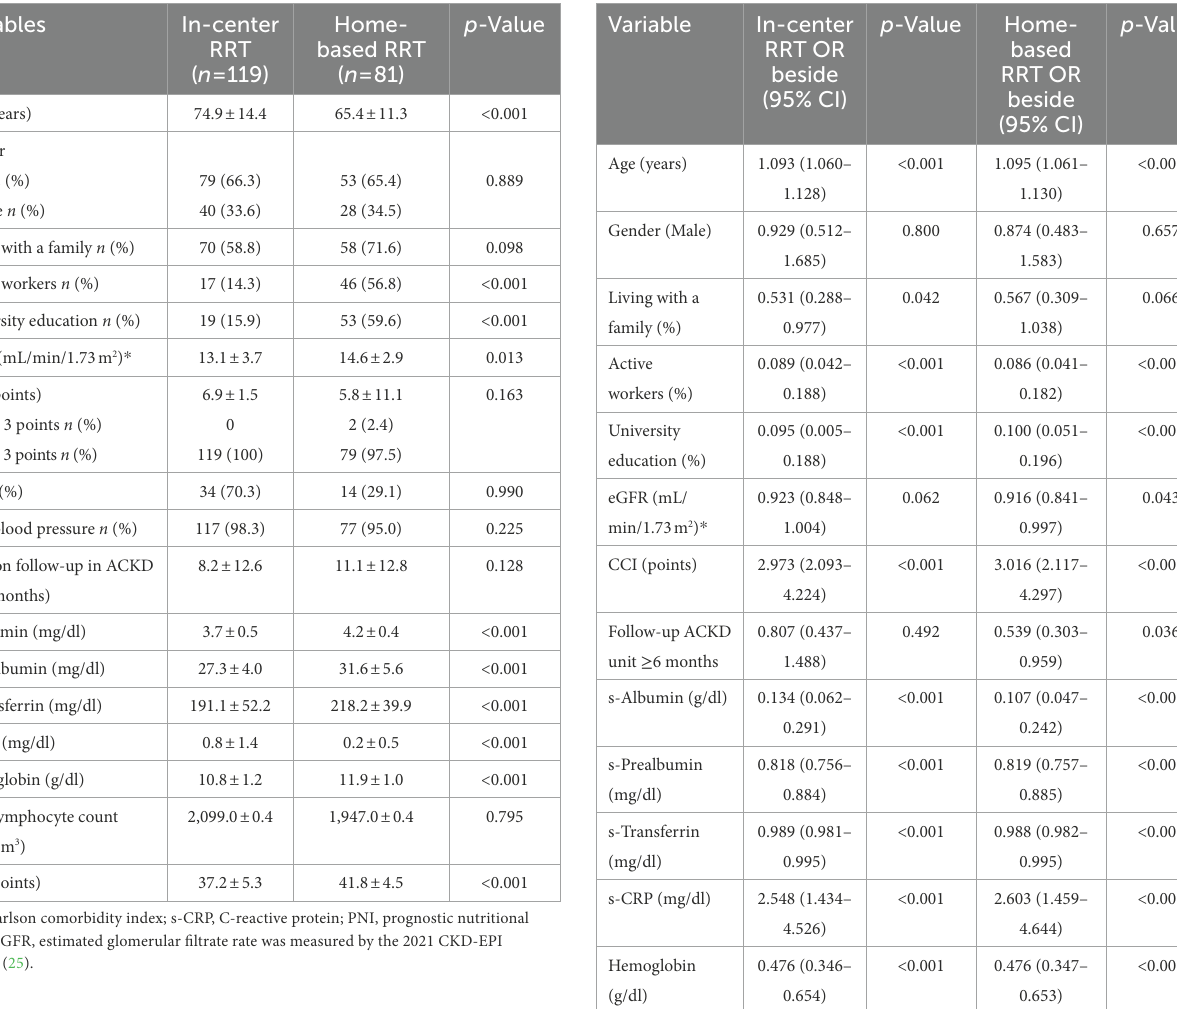
TABLE 3 Comparison of clinical and biochemical parameters of 211 participants in the study according to the decision-making choice of home- based or in-center renal replacement therapy.